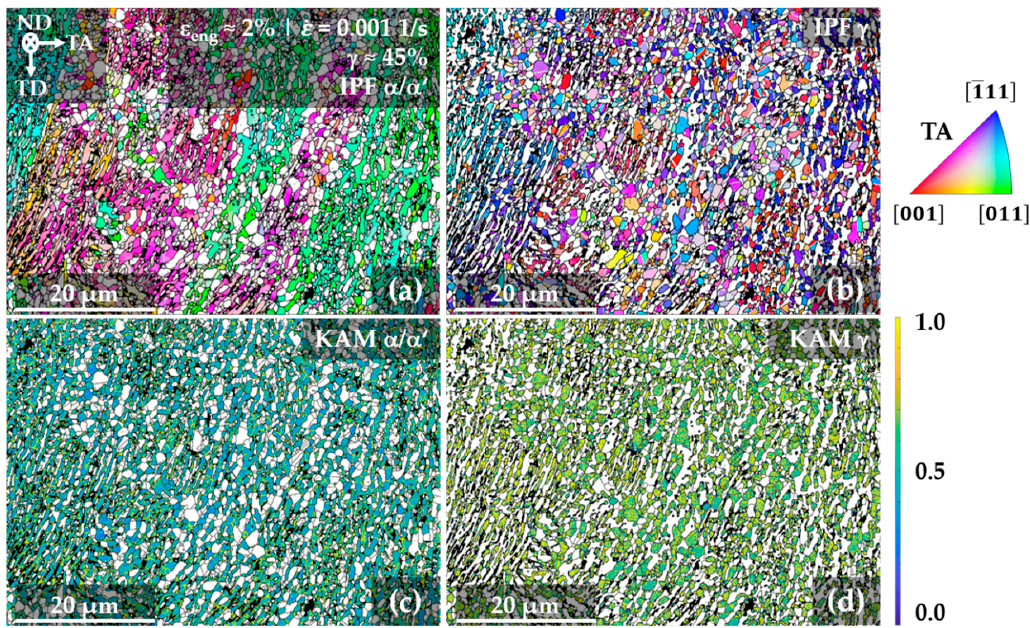
Figure 8. EBSD maps of the X6MnAl12-3 alloy at the end of the discontinuous elastic-plastic transition with ( a , b ) IPF color coding relative to the tensile axis (TA) for ( a ) α and α ’and ( b ) γ . Corresponding KAM maps are shown for ( c ) α and α ’ and ( d ) γ . White areas in (a–d) correspond to ( a , c ) γ and ( b , d ) α or α ’, respectively.